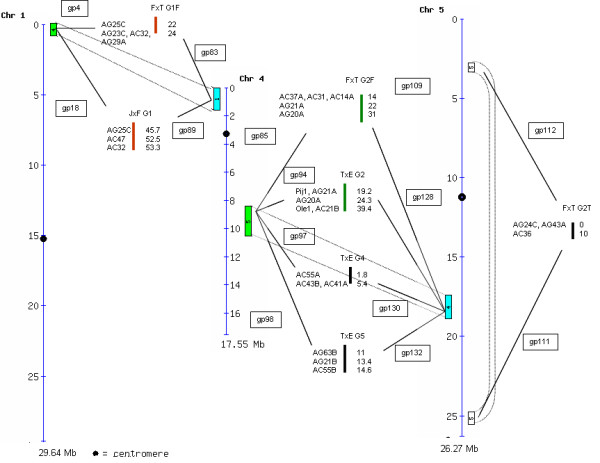
Prunus genomic blocks that map to two distinct Arabidopsis regions. Shown are the Prunus blocks that identified Arabidopsis sister regions generated by the proposed polyploidy event. The Prunus blocks with the same color (red or green) are homologous regions that share more than two anchored ESTs.